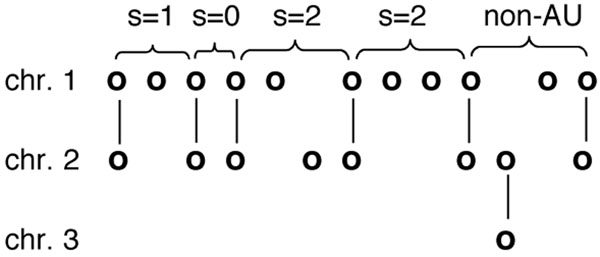
Analytical units (AU) The number of single copy genes s bounded by pairs of duplicates on chromosomes 1 and 2 is the sum of those on chromosome 1 and chromosome 2. The last two pairs of duplicates on chromosomes 1 and 2 do not border an AU because one of the genes between them has a paralog on chromosome 3. From [3].